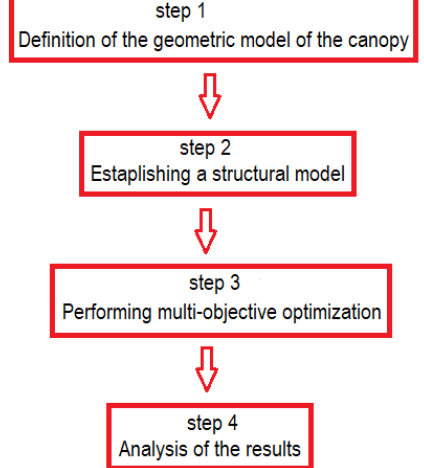
Figure 1. The general scheme of the conducted analysis.